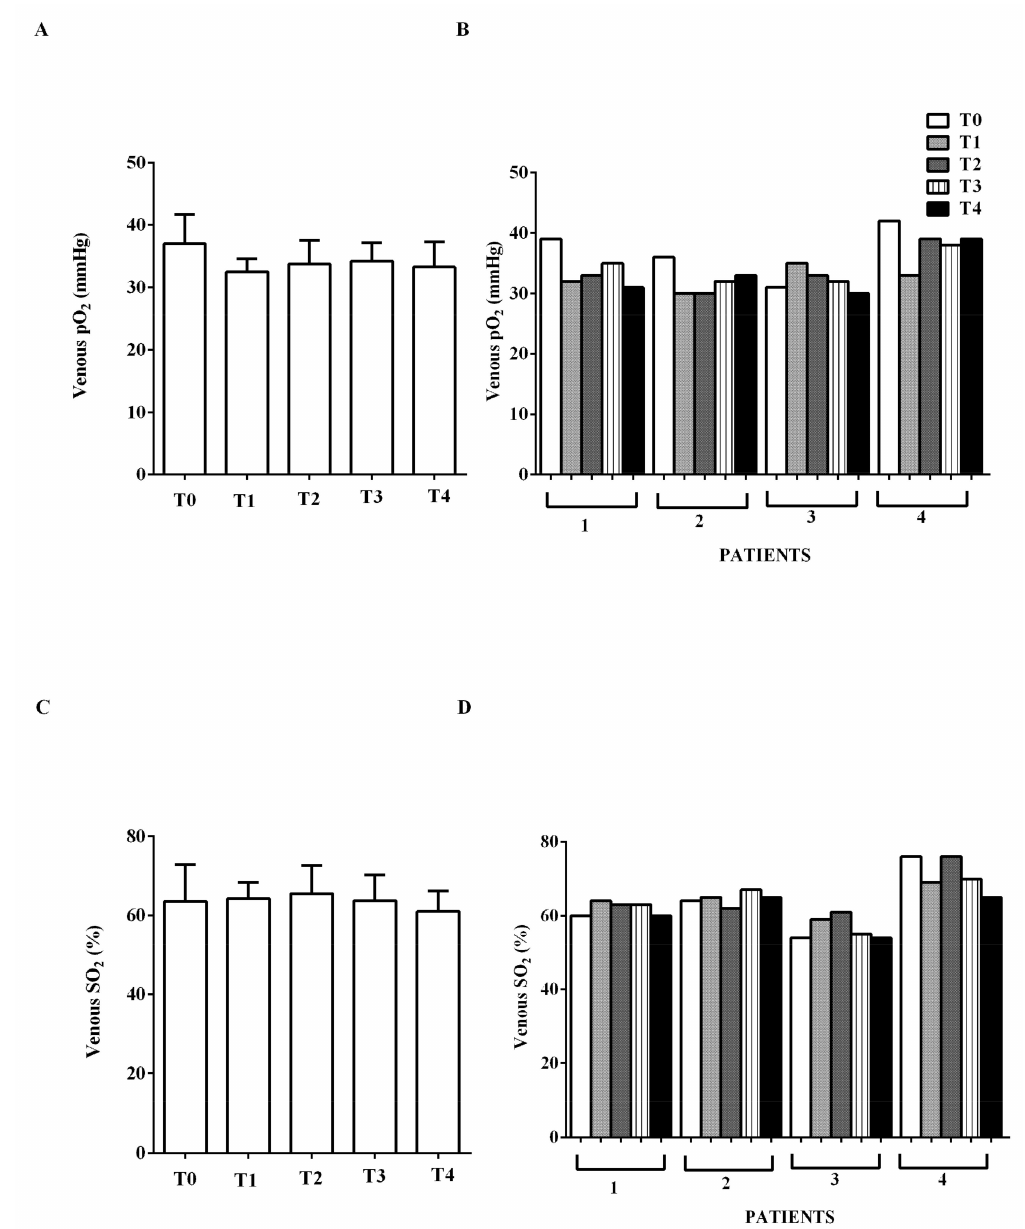
Figure 6. In ( A , B ), e ff ects of levosimendan on venous oxygen partial pressure (pO 2 ) and in ( C , D ), on venous oxygen saturation (SO 2 ). In A and C, values are means ± SD. In B and D, columns represent single